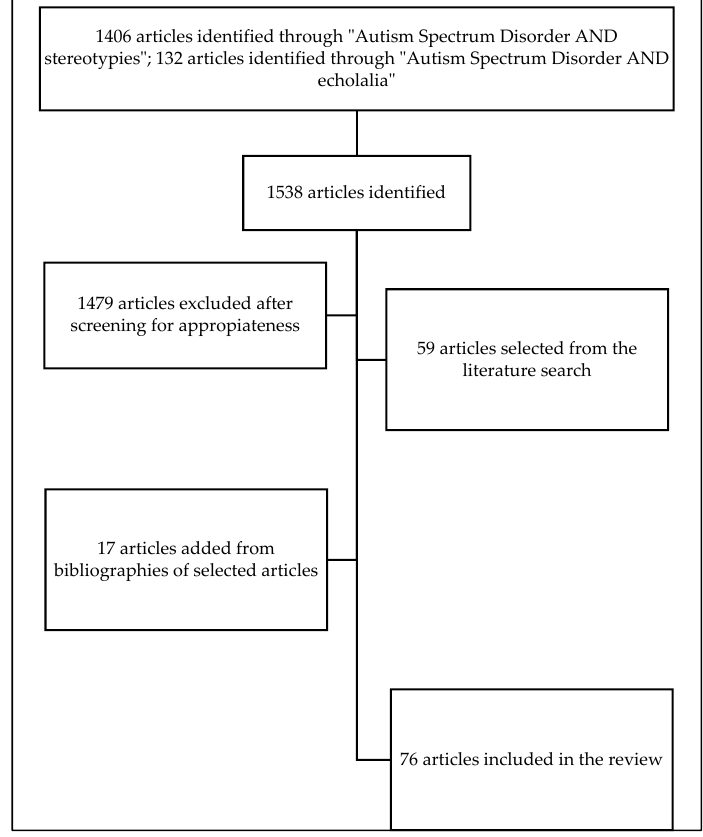
Figure 1. Flowchart of the study.